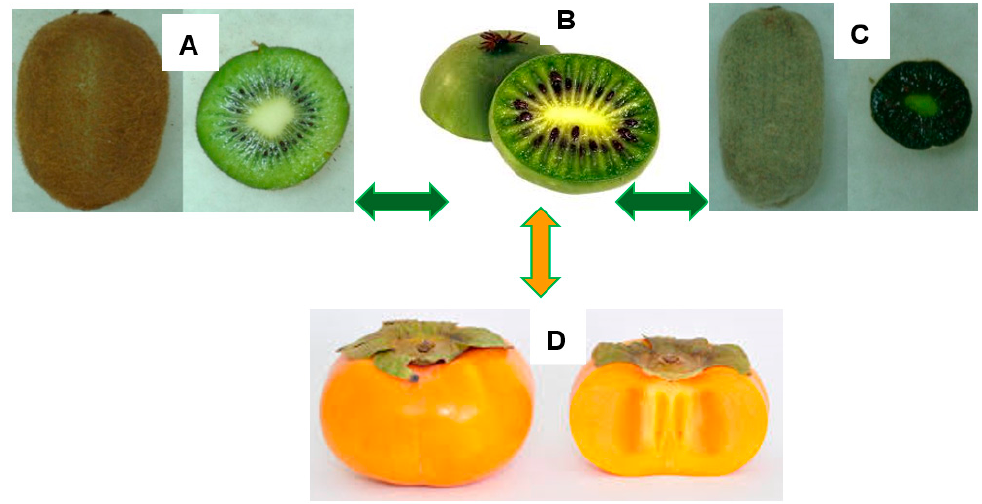
Figure 1. Investigated samples of kiwifruit: ( A – C ) Actinidia ( A .) deliciosa cv.Hayward (ADH), A. arguta cv. Cheongsan (AAC), A. eriantha cv. Bidan (AEB), and ( D ), Diospyros kaki Thunb . cv. Fuyu